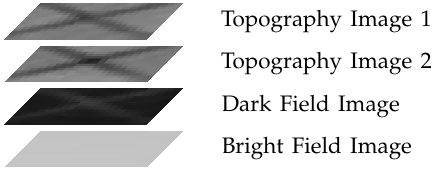
Figure 1. Image stack of a star crack as an